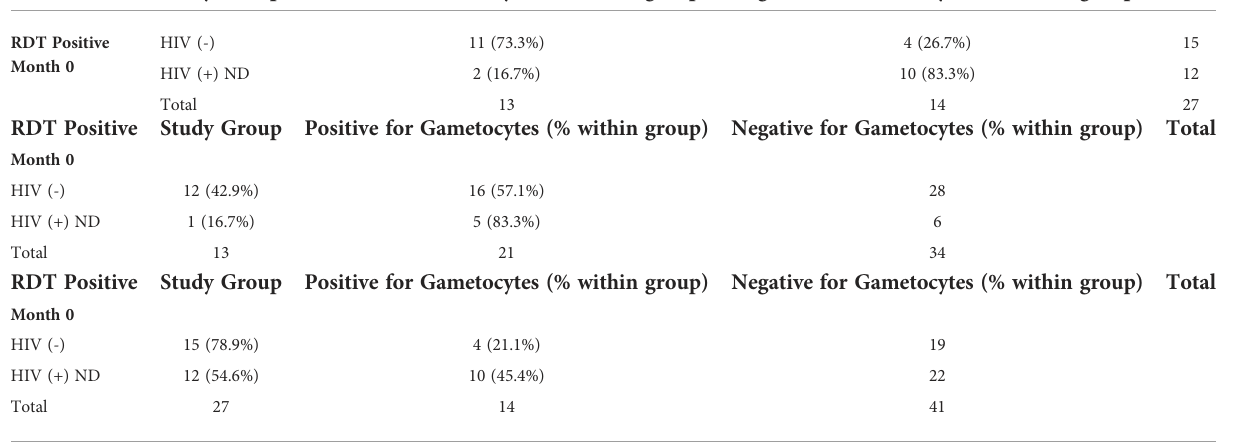
TABLE 5 Comparison of Gametocyte and 18S Positivity at Month 0.